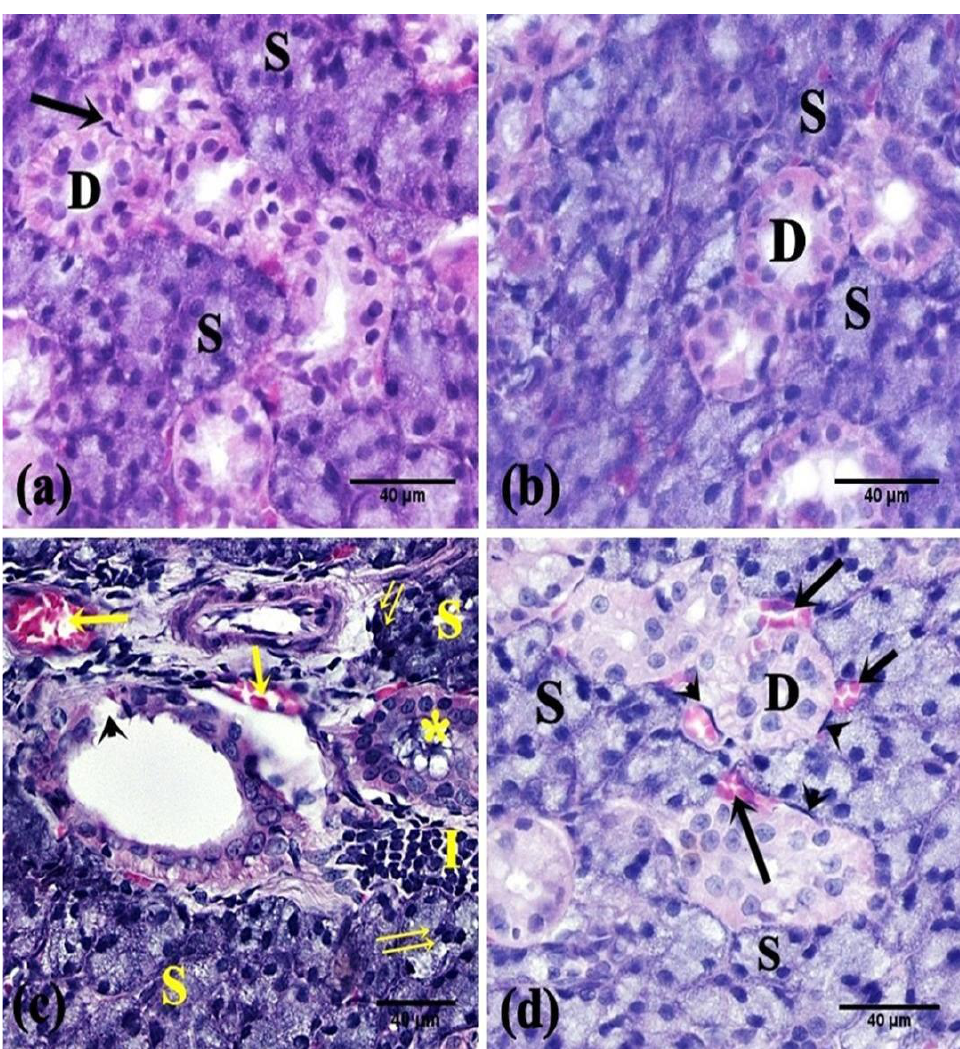
Figure 2. Photomicrographs of the parotid salivary gland of the studied groups. ( a , b ) The control and FEB groups, respectively, showed intact parotid parenchyma; serous acini (S) and striated ducts (D). Note the myoepithelial cells ( ↑ ). ( c ) The 5-FU group showed parenchymal changes; coalesced serous acini (S), pyknotic nuclei ( ↑↑ ), cellular infiltration (I), interrupted lining of striated ducts (arrowhead), retained secretion (*), and dilated congested blood vessels ( ↑ ). ( d ) The FEB+5-FU group showed normal parotid structure; serous acini (S), striated ducts (D), and myoepithelial cells (arrowhead) except for mildly congested blood vessels ( ↑ ). (H&E ×400; 8 rats/group).